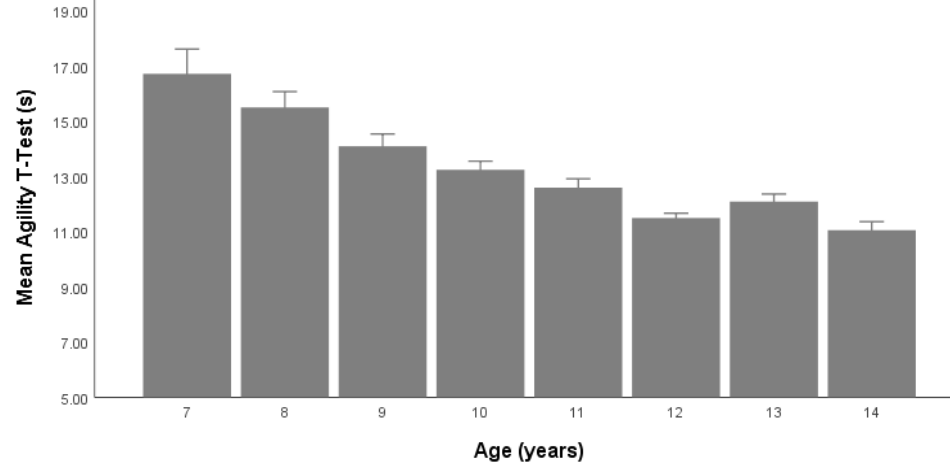
Figure 3. Agility T-Test (s) based on chronological age